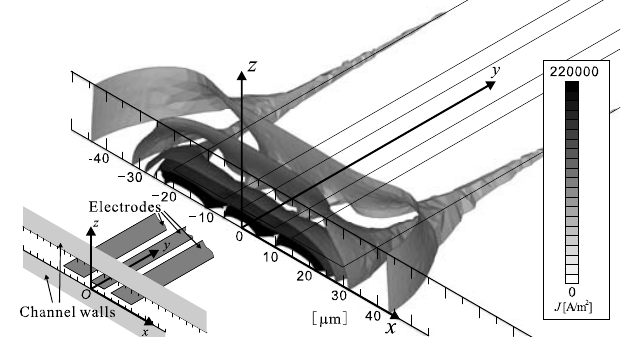
Figure 4. ( a ) Current density distributions around the electrodes; ( b − e ) effects of the geometric parameter of the microchannel and electrodes on the sensor sensitivity in the = 0 case of x RBC